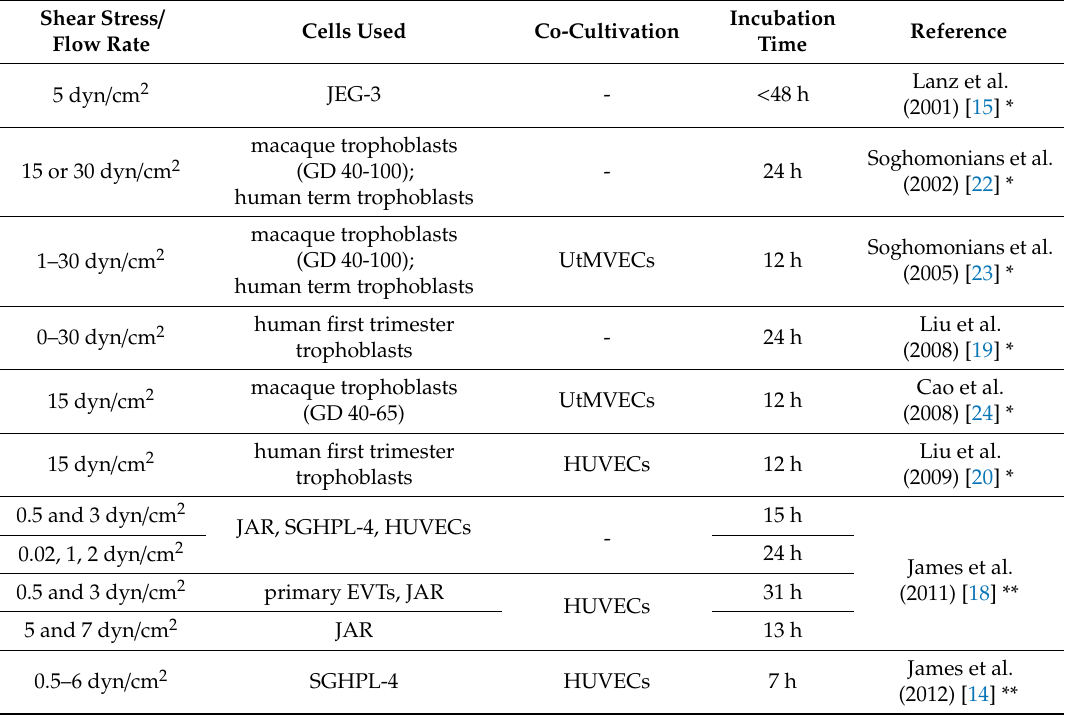
Table 1. Overview of flow culture approaches to study trophoblast